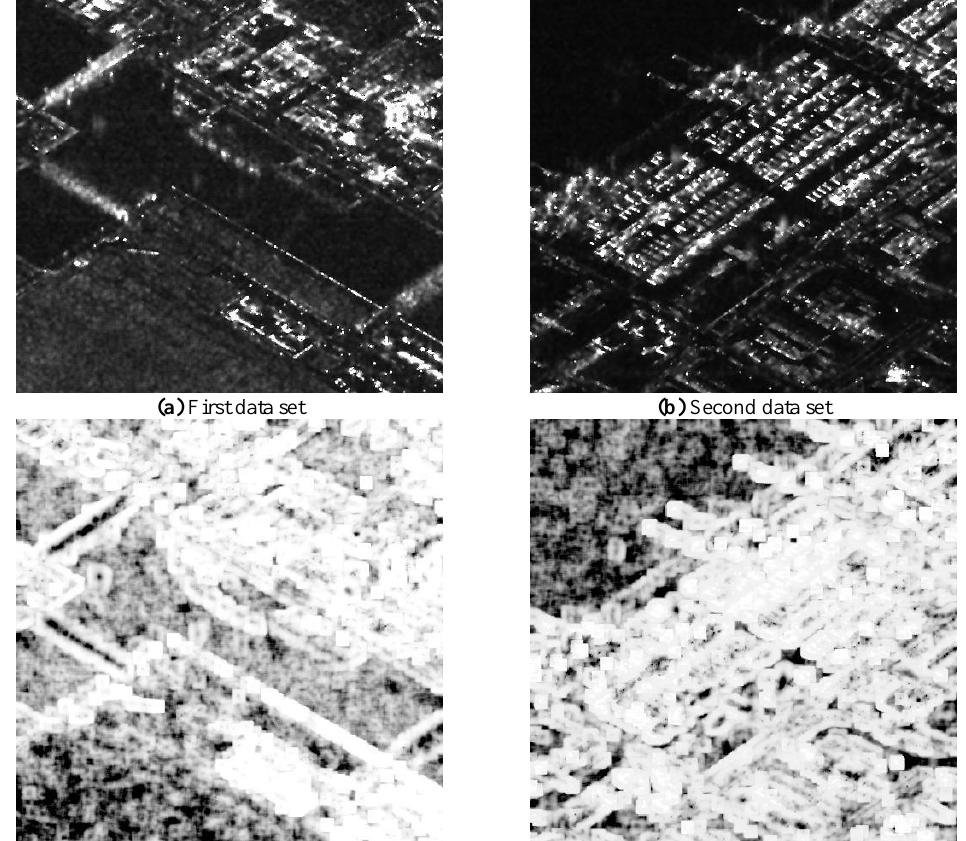
Fig.2 Samples of TerraSAR-X images for the test urban area and their inhomogeneity parameters